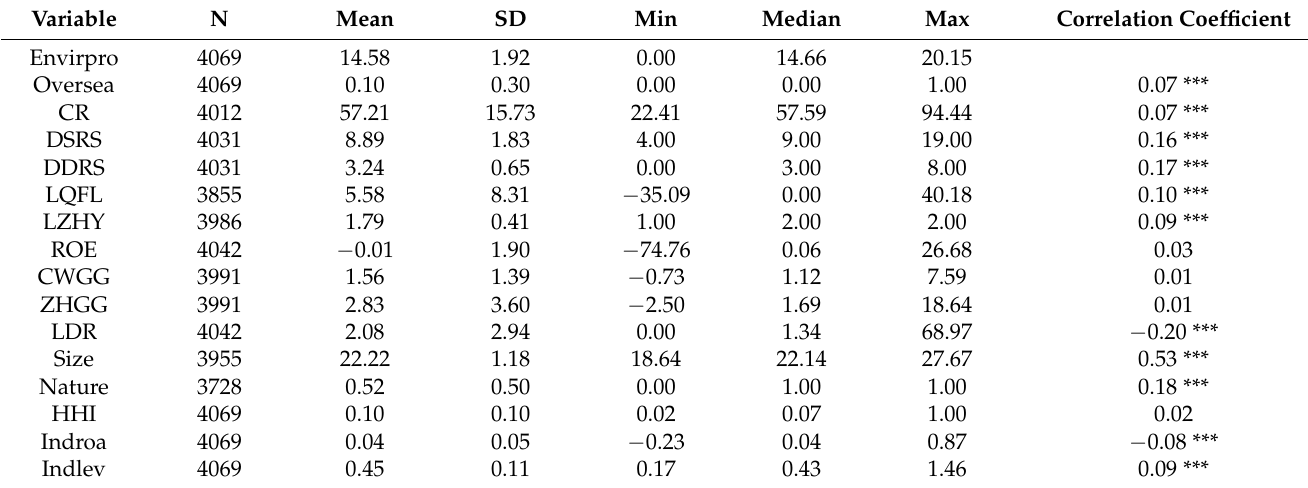
Table 2. Summary of descriptive